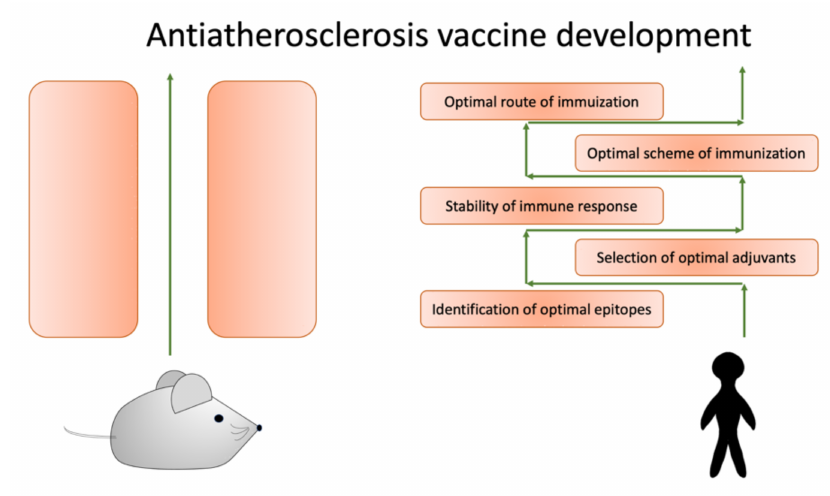
Figure 2. To successfully translate data obtained from model animals, we need to overcome several